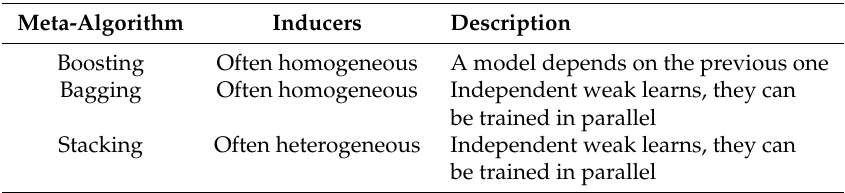
Table 1. Ensemble methods